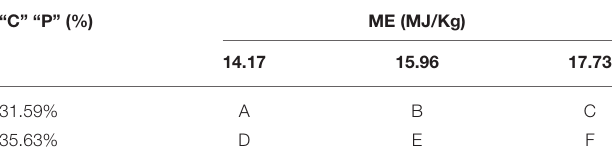
TABLE 1 | The experiment